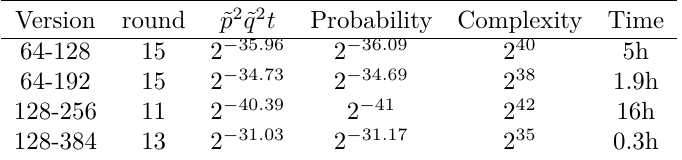
Table 24 and Table 25. The experimental results on one computer equipped with one RTX 2080 Ti are listed in Table 21. Table 21: Experiments on the round-reduced boomerang distinguishers for SKINNY .